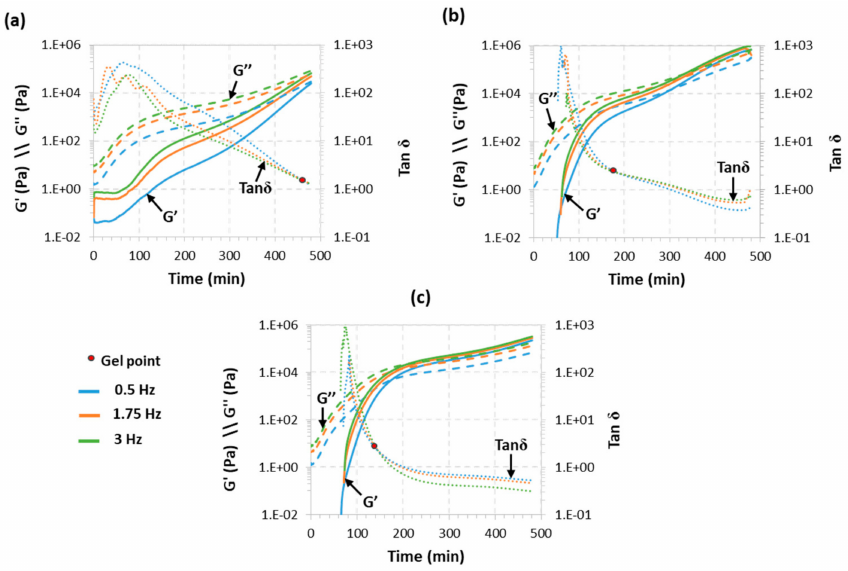
Figure 1. Evolution of storage modulus ( G (cid:48) ), loss modulus ( G ”) and tan δ with time at 30 ◦ C for samples: TCDDA04 ( a ); TCDDA045 ( b ) and TCDDA05 ( c